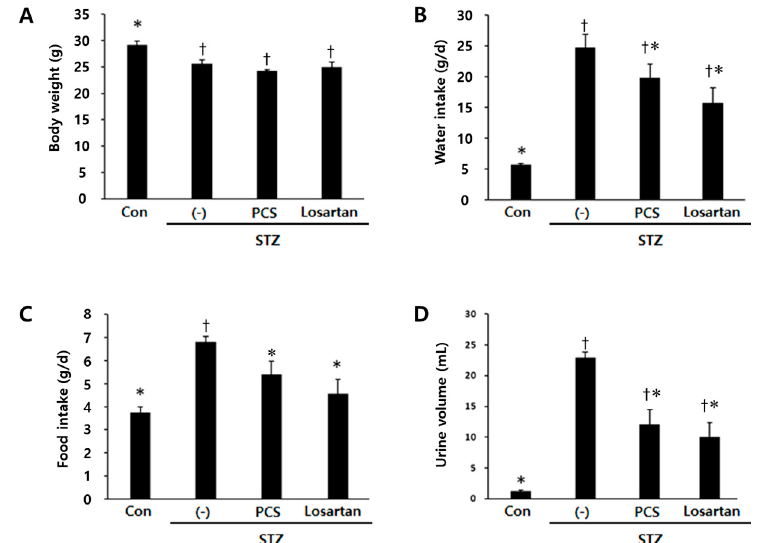
Figure 1. Body weight, food and water intake, and urine volume in PCS extract-treated, STZ-induced diabetic mice. Mice were injected with vehicle (Con) or STZ (50 mg/kg/day) for five consecutive days. STZ-induced diabetic mice (above 300 mg/dL blood glucose) were treated with vehicle (-), PCS extract (500 mg/kg/day), or losartan potassium (10 mg/kg/day) as a positive control for 8 weeks ( n = 8–11/group). ( A ) Body weight after 8 weeks of treatment; ( B ) average water intake over 8 weeks; ( C ) average food intake over 8 weeks; and ( D ) urine volume for 24 h after 8 weeks of PCS extract treatment; †, p < 0.05 vs. Con mice. *, p < 0.05 vs. (-)/STZ mice.